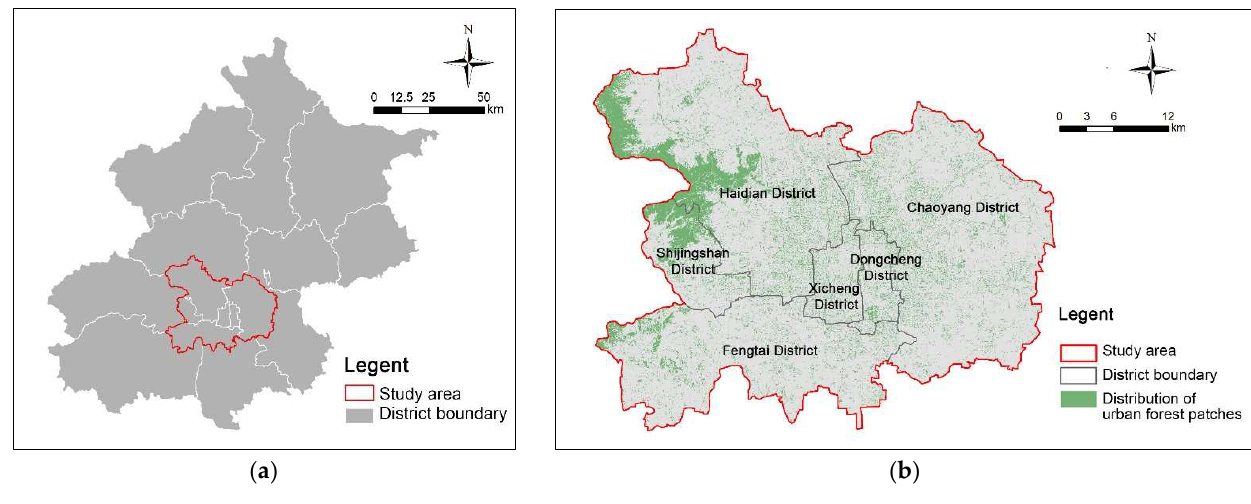
Figure 2. ( a ) The location of the study area; ( b ) the distribution of urban forest patches.